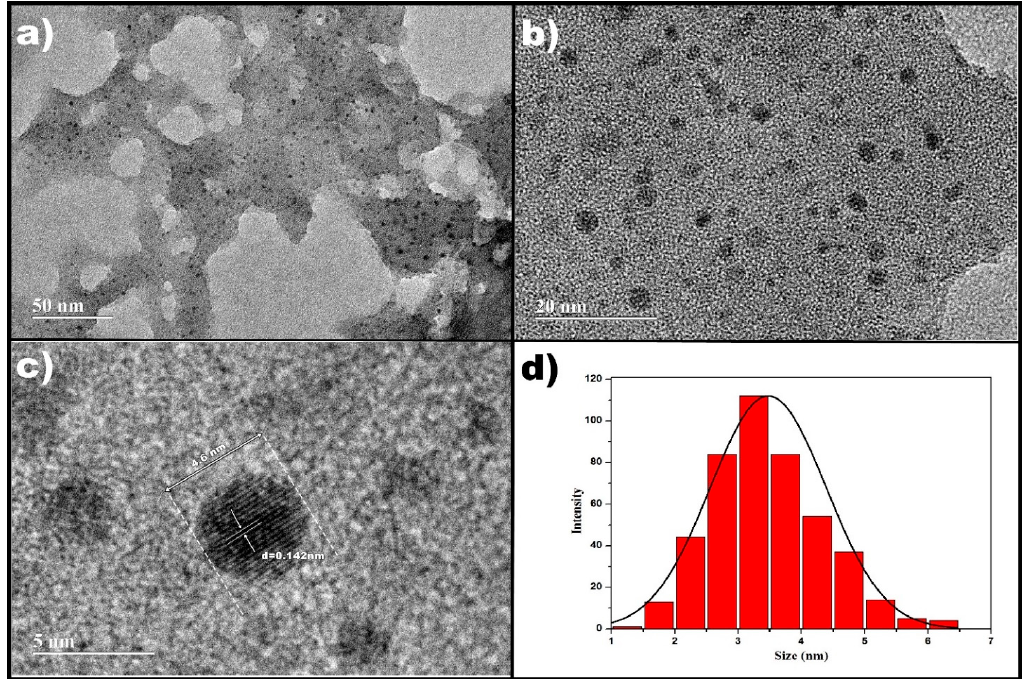
Figure 12. High-resolution transmission electron microscopy. ( a ) Carbon nanoparticles at the scale of 50 nm. ( b ) Carbon nanoparticles at the scale of 20 nm. ( c ) Carbon nanoparticles with approximate diameter of 4.6 nm and highlight of the interatomic distance of 0.142 nm on a 5 nm scale. ( d ) Distribution of the average sizes of CQDs, with average size of 3.5 nm.